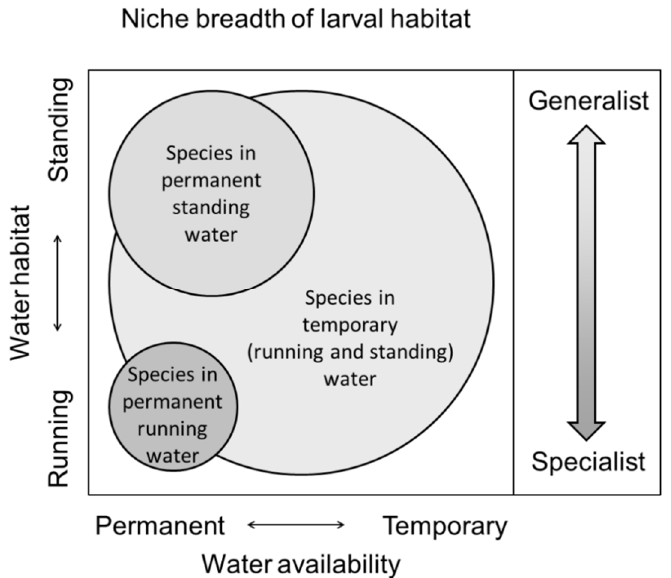
Figure 1. Size of the ecological niche space of the aquatic larvae of the European dragonfly (Odonata) species separated in three habitat categories: permanent running (perennial lotic) water, permanent standing (perennial lentic) water, and temporary (running or standing) water. Color scale to the right represents a gradient going from habitat specialist with a narrow niche breadth to habitat generalist with a broad niche breadth as also illustrated with the size of the ecological niche space of three habitat categories.